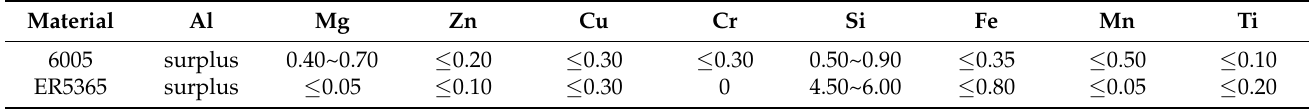
Table 1. Chemical composition of 6005 aluminum alloy and ER5356 welding wire